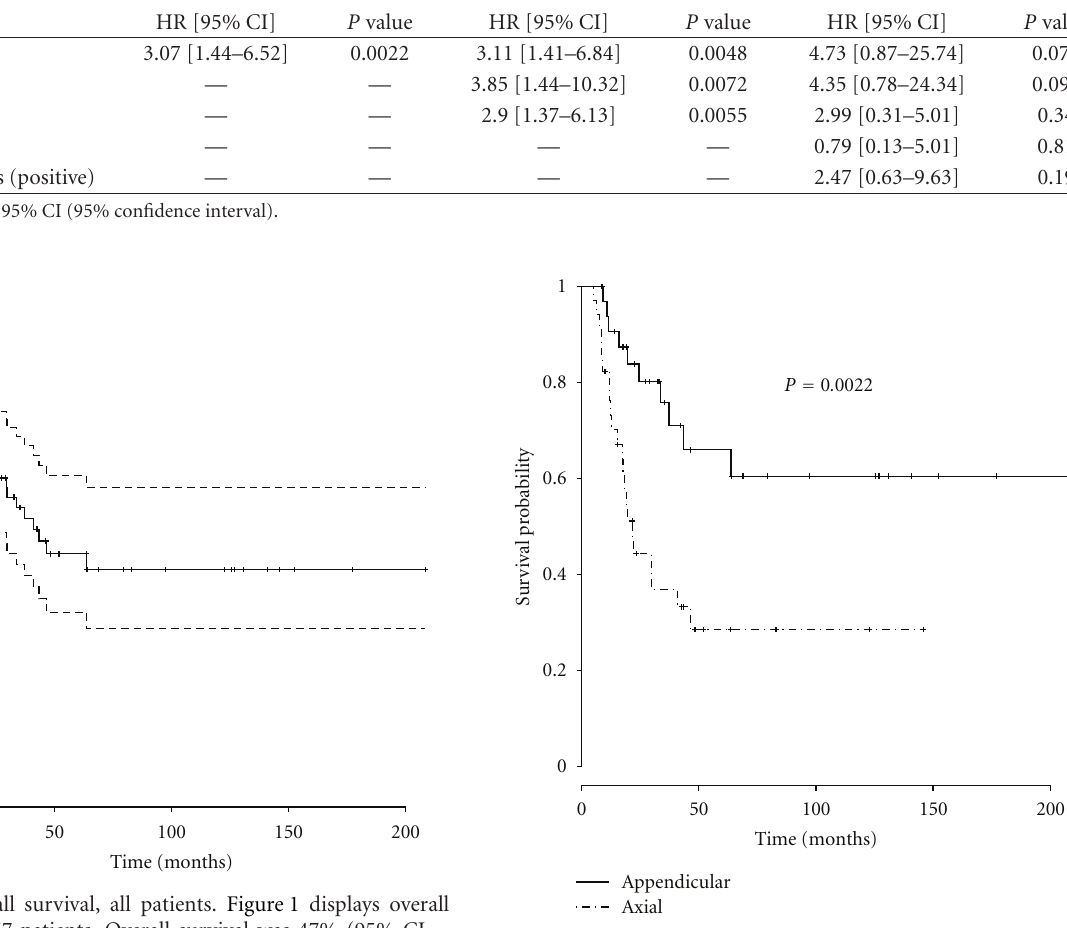
Figure 2: Overall survival, axial versus appendicular. Figure 2 depicts overall survival as a function of anatomic location. Overall survival for the axial group was 29% (95% CI = 0.16–0.52) at 5 years and 10 years. Overall survival was 66% (95% CI = 0.50–0.88) at 5 years and 61% (95% CI = 0.43–0.84) at 10 years. The di ff erence in overall survival between the 2 groups was statistically significant ( P = 0 .